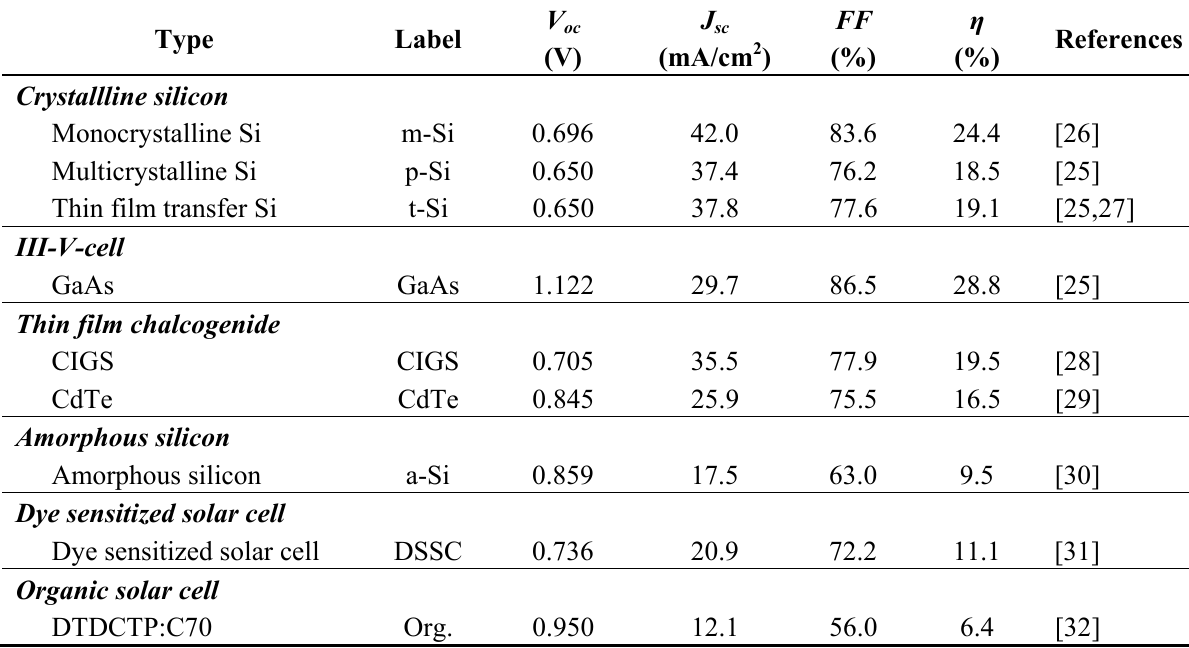
Table 1. An overview of the solar cells considered in this study, with their characteristics: open circuit voltage V , short circuit current density J oc conversion efficiency η under standard test